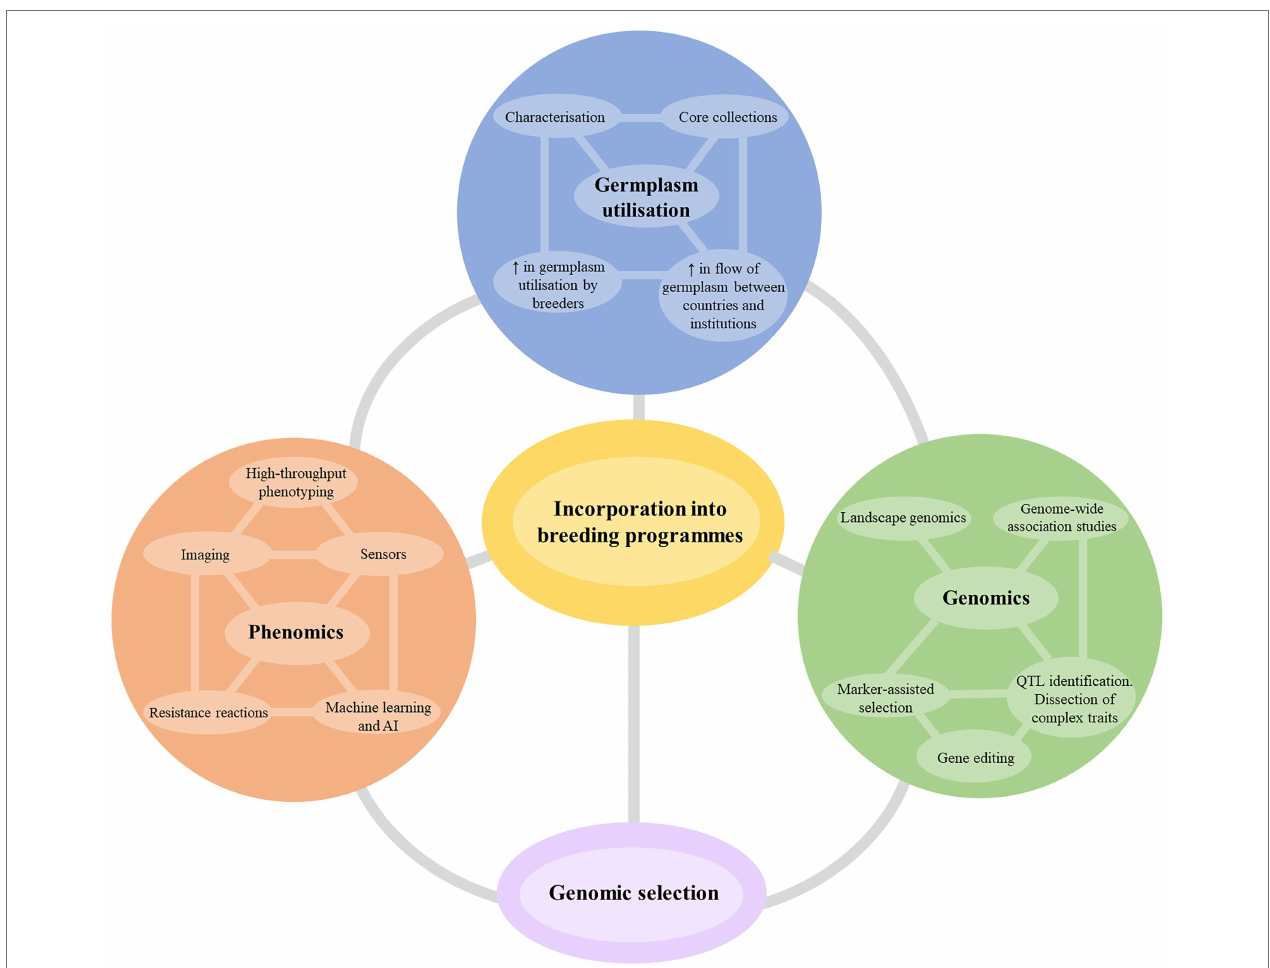
FIGURE 4 | The potential future strategies for improvement of host plant resistance in cotton breeding programs. AI, artificial intelligence; QTL, quantitative trait